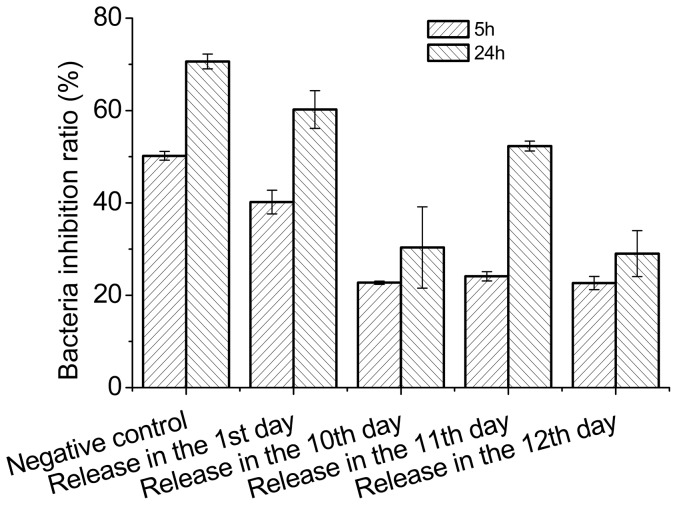
Antimicrobial activity against Escherichia coli of the native BF-30 and the peptide released from the microspheres on the 1st,10th, 11th, and 12th days.